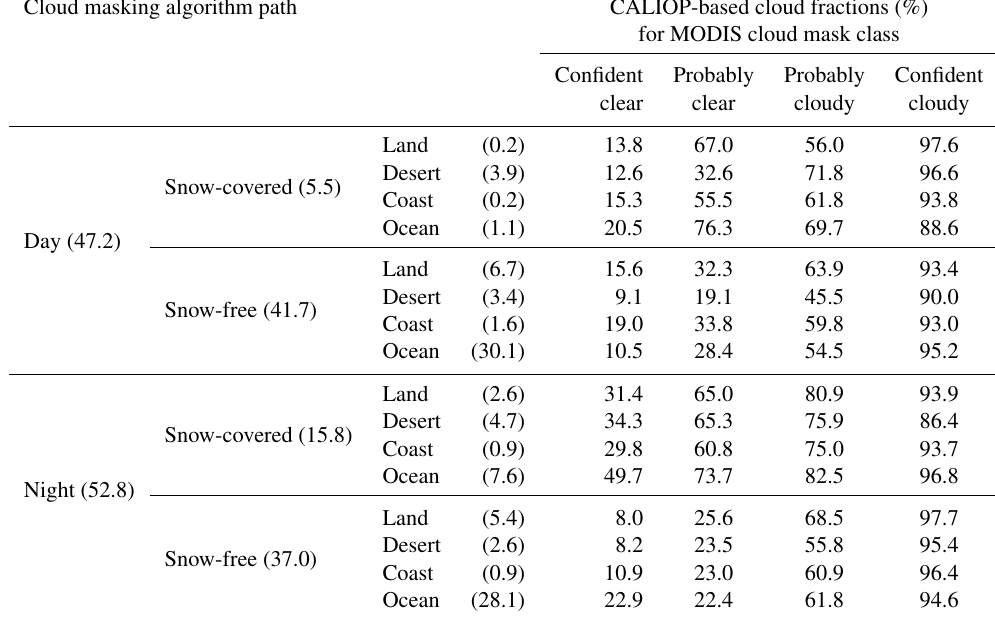
Table 3. CALIOP-based cloud fractions for MODIS cloud mask classes, calculated individually for each MODIS algorithm path. Note that more paths are reported here than in the MODIS project. Snow-covered ocean, land, desert, and coast constitute a single path in the operational algorithm, while here they are reported individually to highlight how snow impacts the results. The sunglint path is missing as CALIOP does not sample over sunglint areas. Numbers in brackets refer to how frequently (% of n ) a given algorithm path was executed, n = 33, 793,